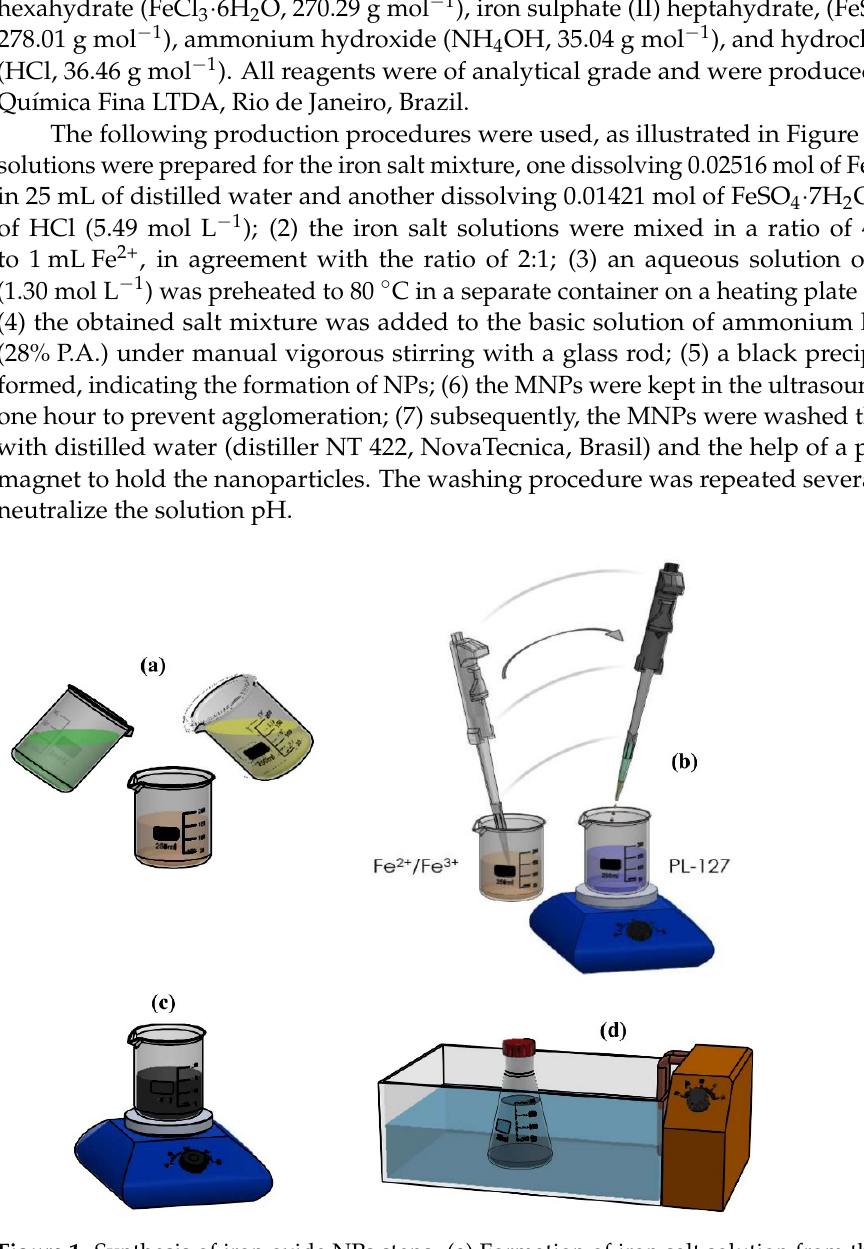
Figure 1. Synthesis of iron oxide NPs steps. ( a ) Formation of iron salt solution from the Fe 2+ and Fe 3+ mixture, ( b ) addition of the iron salt mixture to the basic solution of NH 4 OH, ( c ) Becker with MNP precipitate, and ( d ) MNP sample in an ultrasound bath.